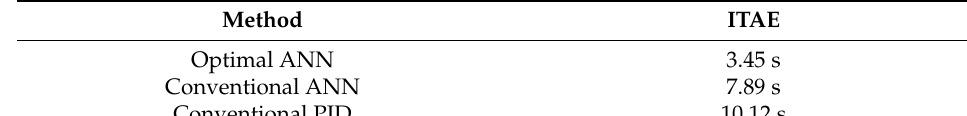
Table 8. ITAE for optimal ANN, conventional and PID methods.